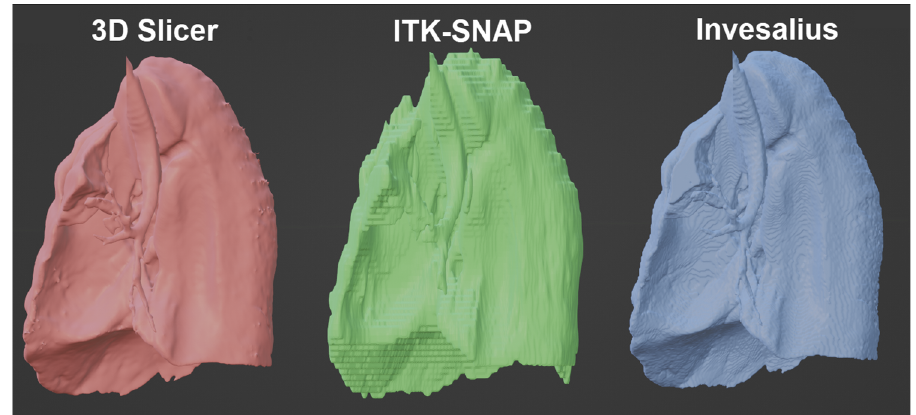
Figure 11. Comparison of the tumor volume obtained from the 3 software.